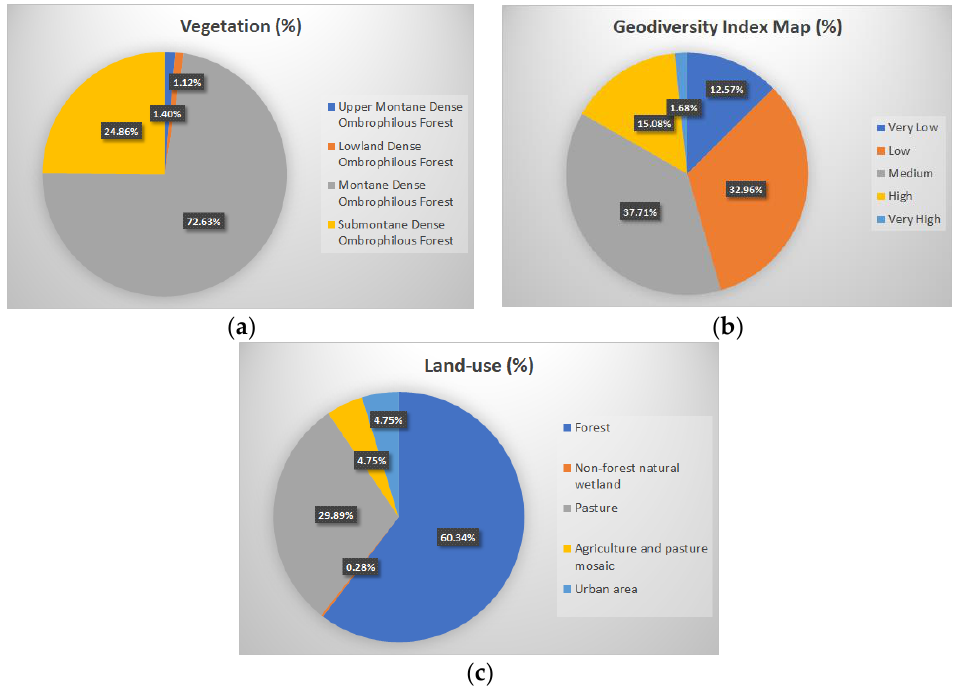
Figure 11. Percentage of each class of the vegetation map ( a ), geodiversity index map ( b ), and land-use map ( c ).